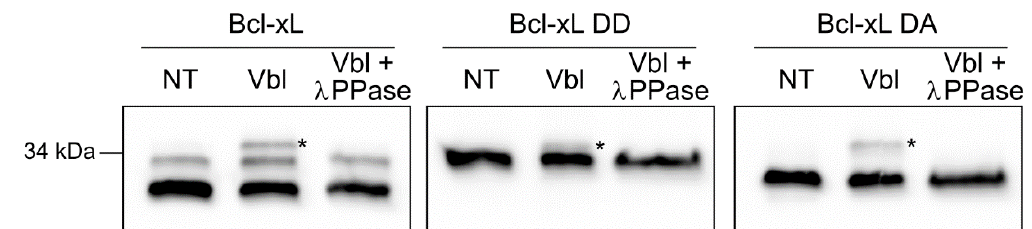
Figure 3. Electrophoretic separation of deamidated and phosphorylated proteins: HCT116 cells expressing the indicated forms of Bcl-x L were infected with lentiviruses to silence the expression of endogenous Bcl-x L (the genes encoding the proteins re-expressed are modified so that their mRNA is not targeted by the ShRNA used to silence endogenous Bcl-x L ). Cells were either left untreated or exposed to Vinblastine (100 nM) for 32 h to induce Bcl-x L phosphorylation. Total proteins were extracted and, where indicated, were treated with λ -phosphatase. Twenty micrograms of proteins were separated on taurine–glycine mini-gels, and immunodetection of Bcl-x L was performed.